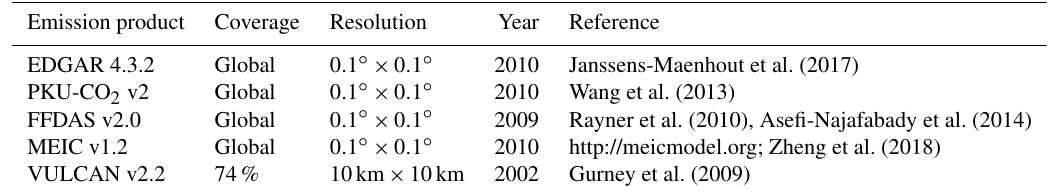
Figure 7. Cumulative distributions of the number (dashed lines) of emission clumps and of the emissions (solid lines) of the clumps for three categories of clumps (see text). Table 2. The alternative emission maps used to compare the results of